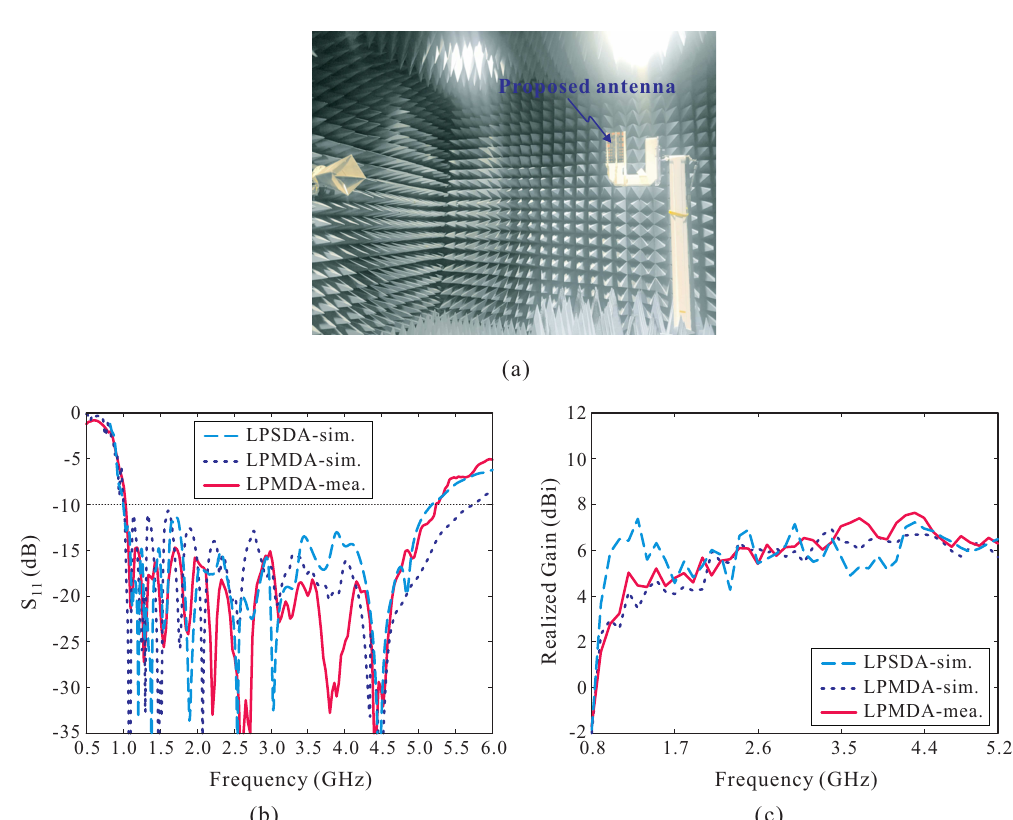
Figure 3. ( a ) Measurement setup for the far-field radiation pattern in the anechoic chamber; ( b ) Reflection coefficients; ( c ) Realized